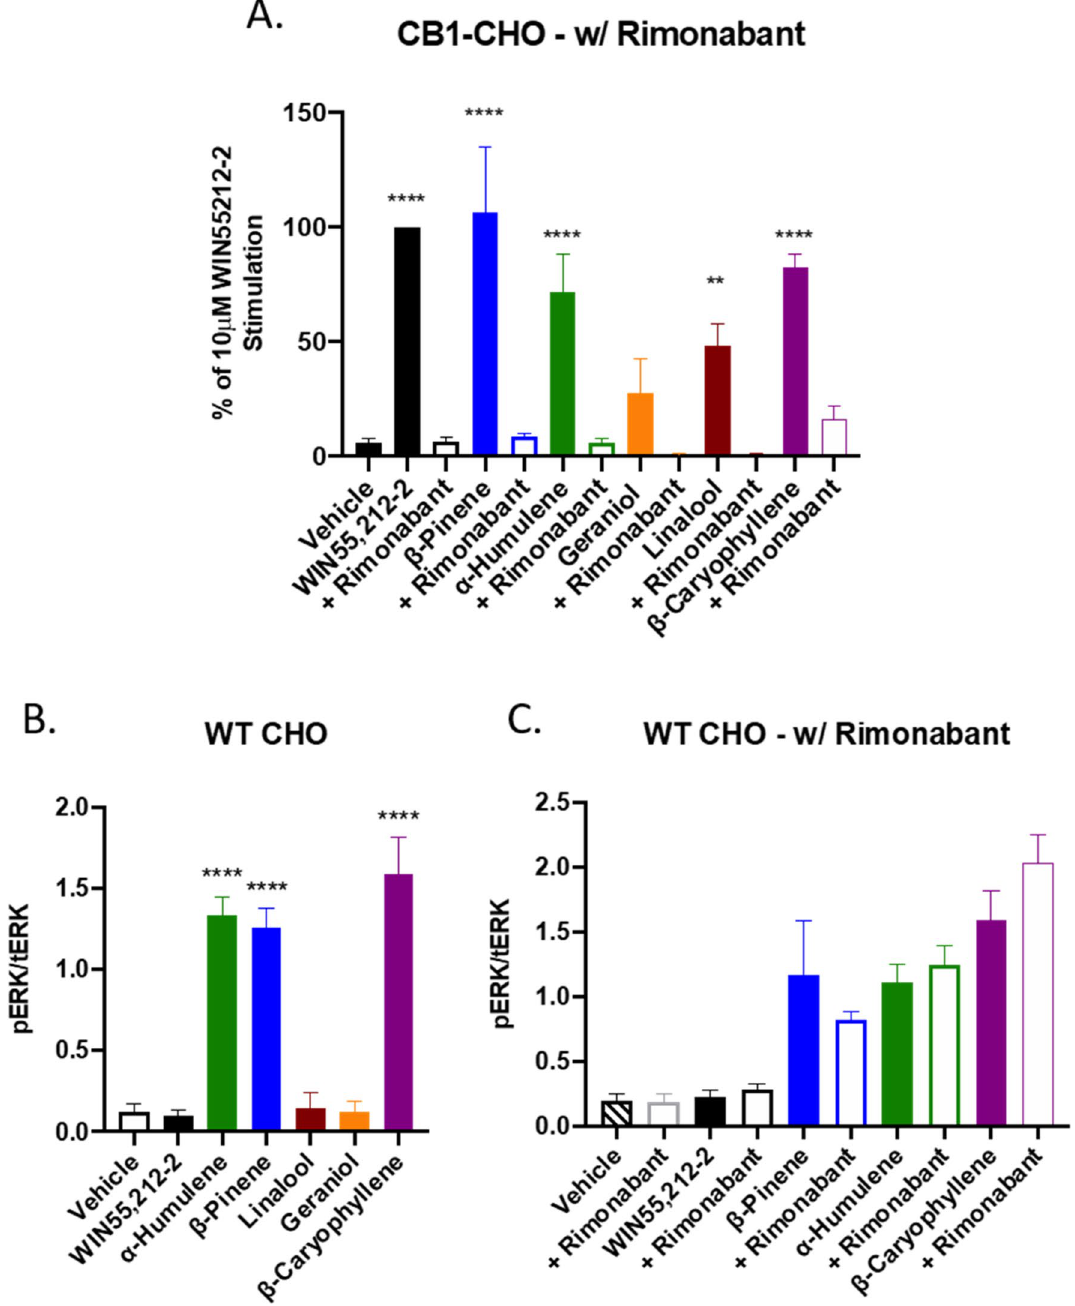
Figure 7. Terpenes Induce CB1-Dependent and Independent Signaling In Vitro. ( A ) CB1-CHO cells were serum starved for 1 h then pretreated with 10 μM rimonabant or vehicle for 5 min. Cells were then treated with 500 μM terpene, 10 μM WIN55,212-2, or matched vehicle, for 5 min. Lysates were then subjected to Western analysis and blotted for phospho-ERK and total-ERK (see Methods). Graph represents the quantitation of ERK phosphorylation induced by terpene and rimonabant combinations (pERK/tERK). Data expressed as a % of WIN55,212-2 stimulation (n = 3 independent experiments for each). ( B ) WT CHO cells were serum starved for 1 h then treated with 500 μM terpene, 10 μM WIN55,212-2, or matched vehicle, for 5 min, and analyzed as above. ( C ) WT CHO cells were serum starved for 1 h, pretreated with 10 μM rimonabant or vehicle, then treated with 500 μM terpene, 10 μM WIN55,212-2, or matched vehicle, for 5 min, and analyzed as above. Data analyzed via one-way ANOVA, Dunnett’s post hoc; ** p < 0.01, **** p < 0.0001, compared to vehicle